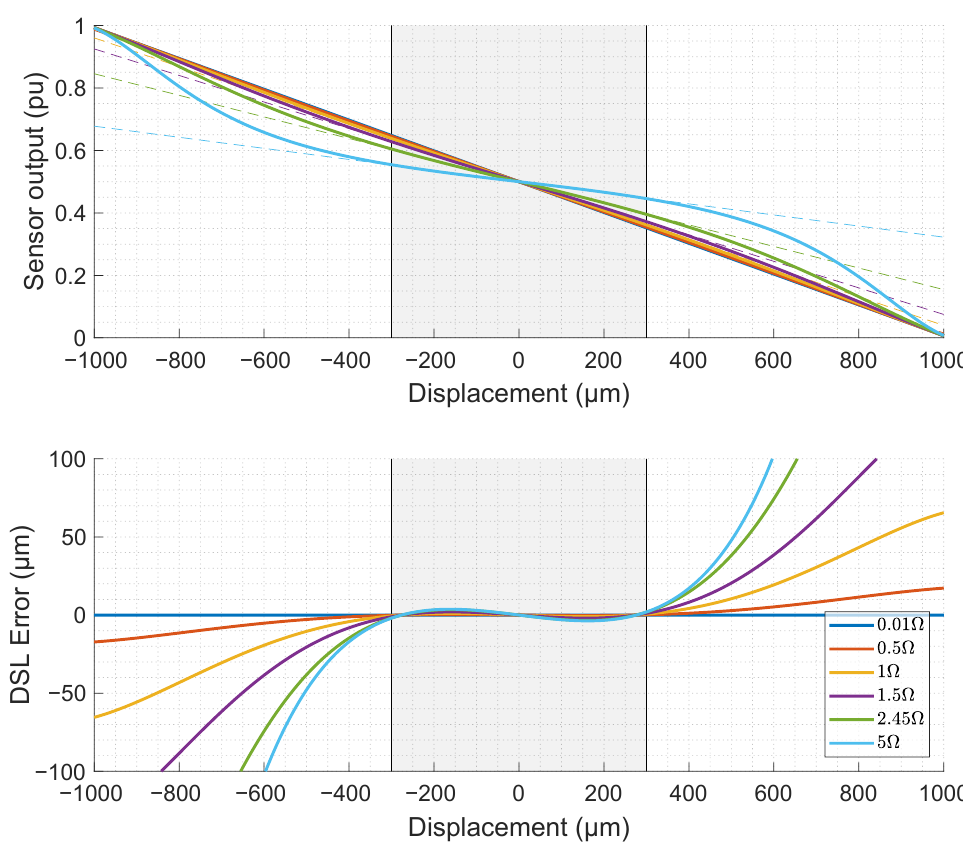
Figure 2. Effect of measurement coil stray series resistance on the linearity of the inductive measure- ment bridge output based on an analytical model of the electromagnetic circuit. Output error (lower figure) calculated as deviation from the best straight-line fit (dashed line) over the measurement range (grey